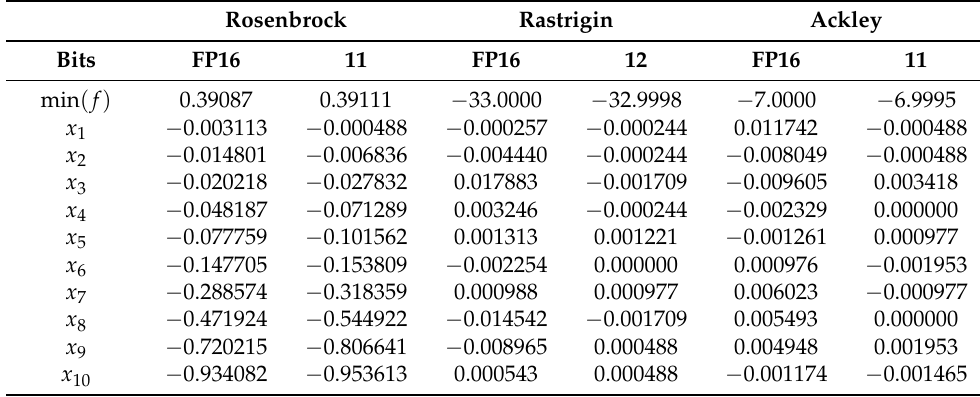
Table 7. Variables values for the minimum function value for FP16 simulation, and the integer arithmetic simulation. The shown numbers 11, 12, and 11 correspond to the used bits in the fractional part for integer arithmetic, which also correspond to the same mean of FP16 results for each function in Tables